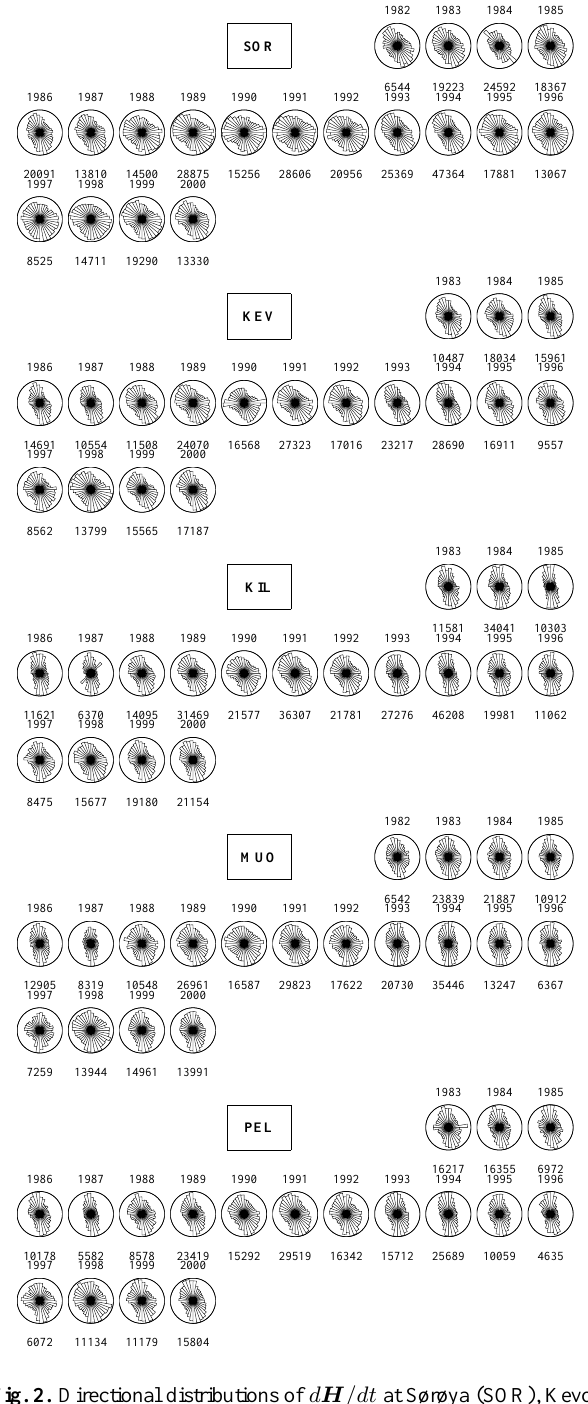
Fig. 2. Directional distributions of d H /dt at Sørøya (SOR), Kevo (KEV), Kilpisj¨arvi (KIL), Muonio (MUO) and Pello (PEL) from 1982 to 2000. Only timesteps fulfilling the condition | d H /dt | > 1nT/s are included. The sampling interval was 20 s until November 1992, and after that 10 s. For consistency, 10 s values were averaged to 20 s. The eleven years of the sunspot cycle 22 are in the middle row. The geographic north direction is upwards. The distribution patterns are normalized separately for each year for better readabil- ity. The number of timesteps is given under each subplot. Data from 1982 to 1983 were available only of short periods, and only about half of 1985 to 1987 was covered at KIL. The geomagnetic latitudes of the stations are between 63 ◦ and 67 ◦ .